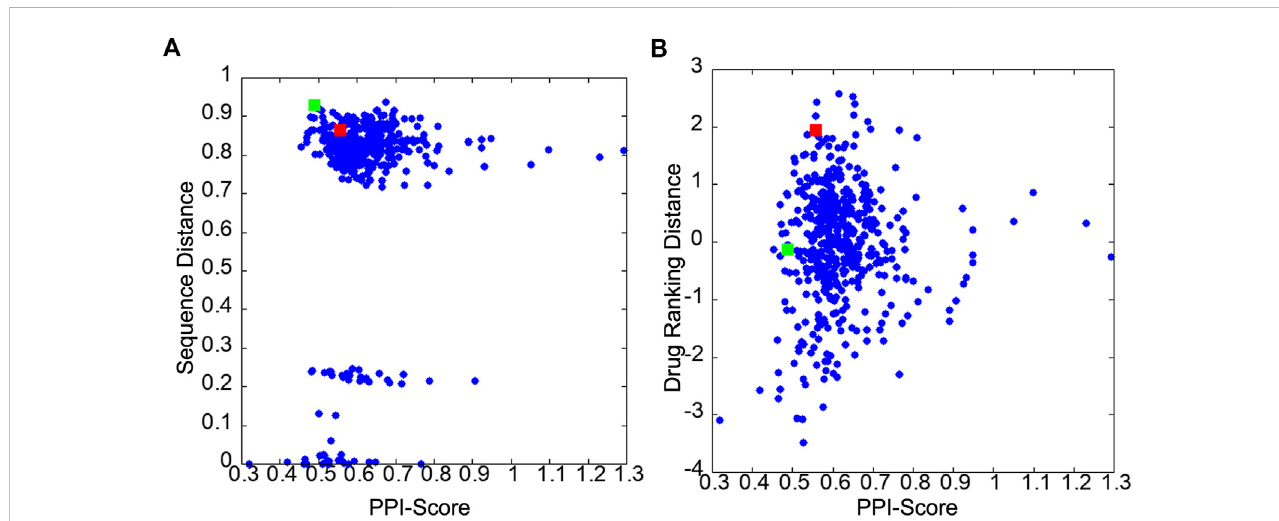
FIGURE 3 ScoredistributionofPPIScoreof32PPIsinthe2P2Idatabase. (A) scatterplotofthePPIScoreandthesequencedistance. (B) scatterplotofthePPIScore and the drug ranking distance. The red and green squares are 2FLUXP/1YCRAB and 1TUEAB/4GQ6AB pairs, which are discussed in the